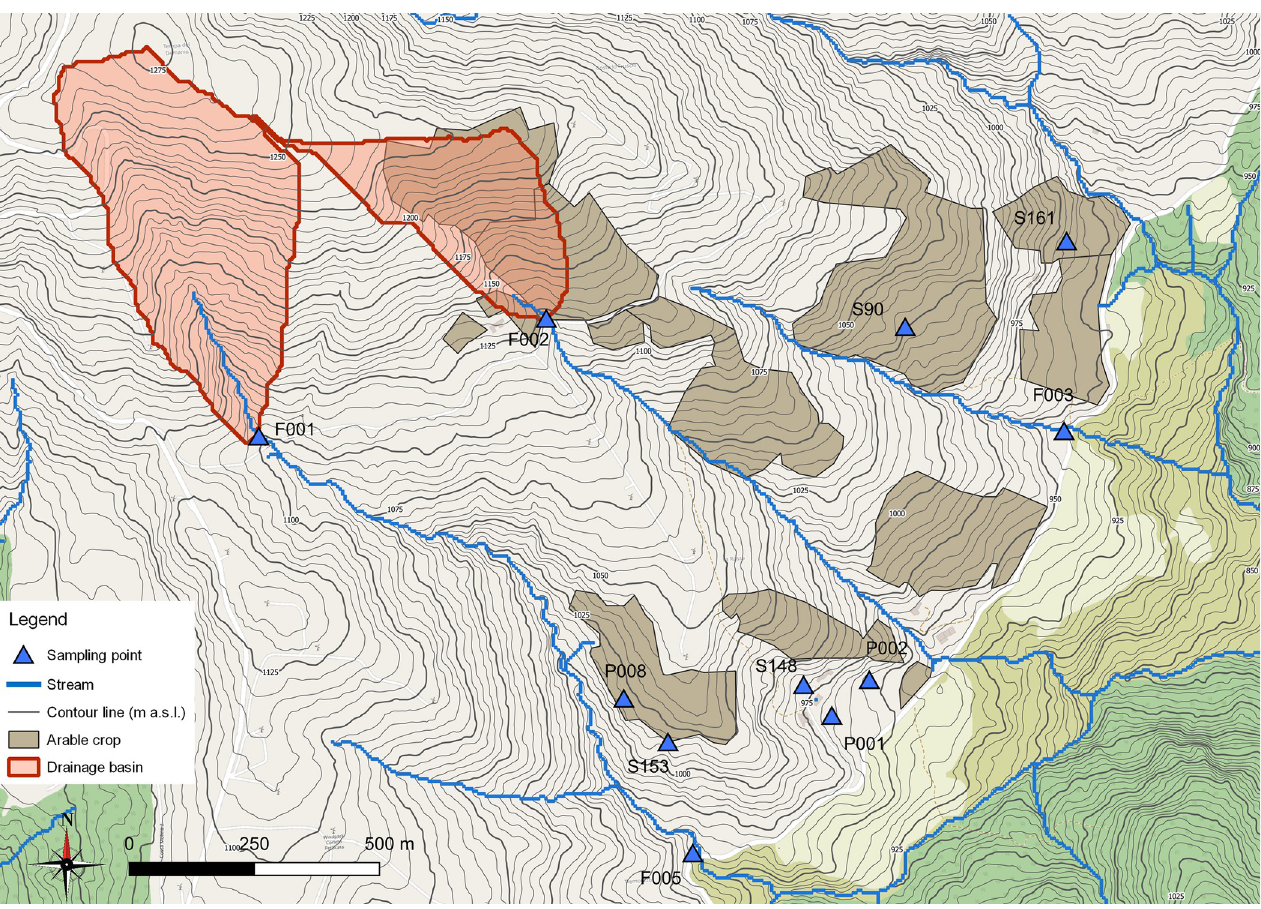
Fig 16. Arable crops in the study area and watersheds of F001 and F005. Base map and data from OpenStreetMap and OpenStreetMap Foundation.